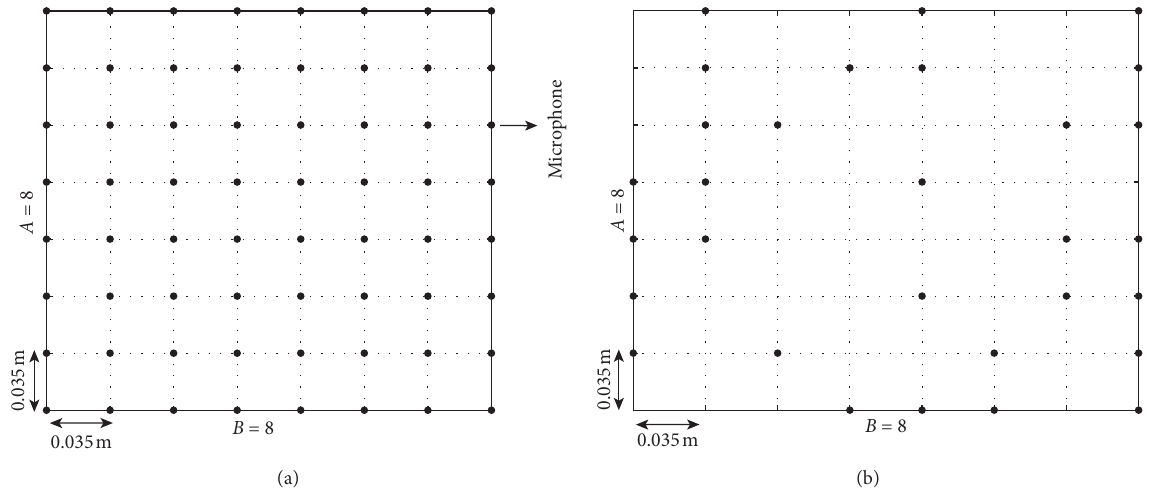
Figure 1: Sketch maps of (a) standard uniform rectangular and (b) non-uniform microphone